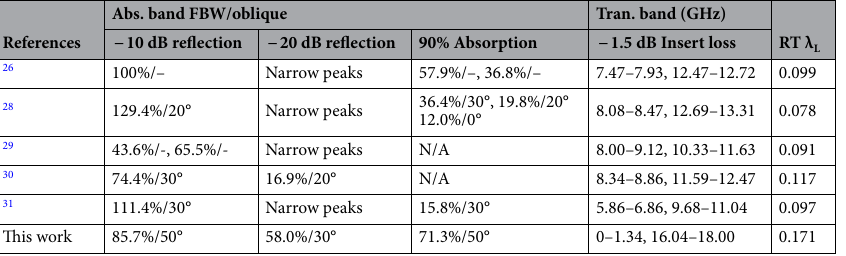
Table 1 lists the performance comparisons between the proposed HADTR and others in the literature. Though the − 10 dB reflection band of some designs are larger than the proposed HADTR, they show the characteristic of sensitive oblique incidence performance. At the same time, the range of their − 20 dB reflection bands is limited, but the proposed HADTR has wide − 20 dB reflection band when the oblique incidence angle is lower than 30°.